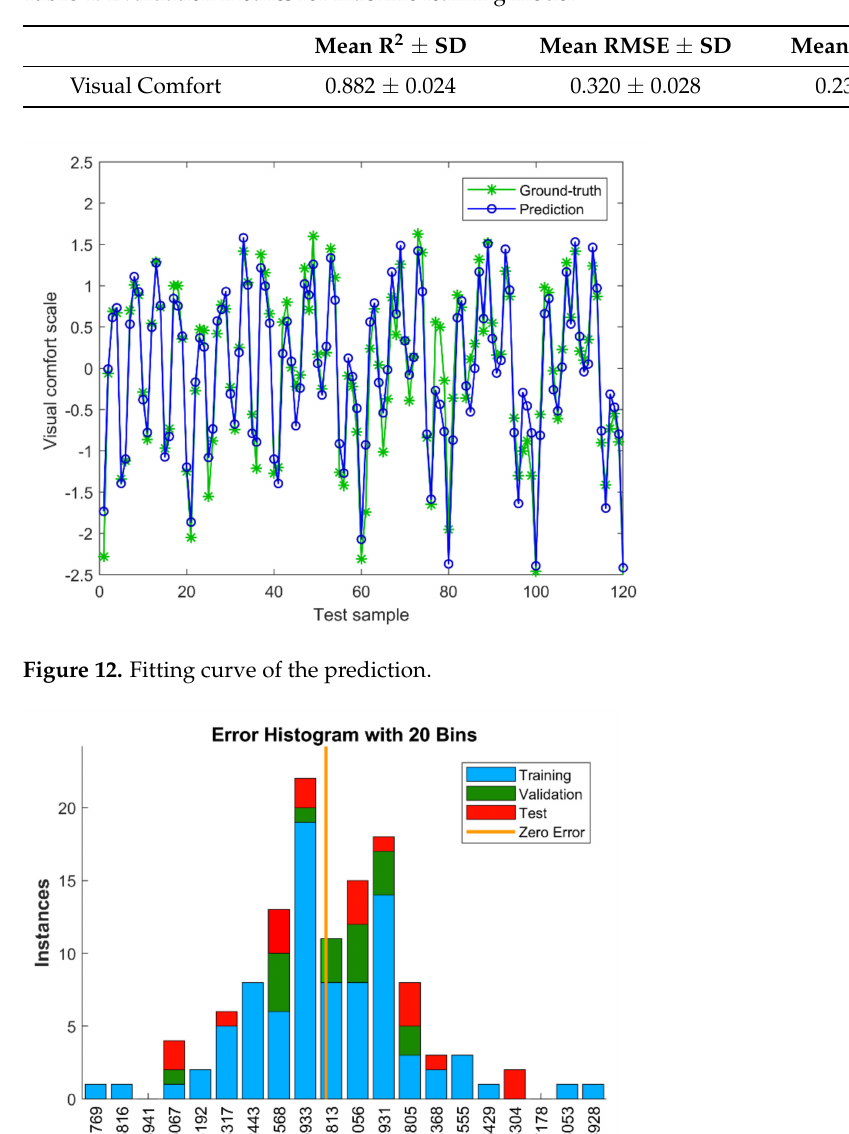
Table 4. Evaluation metrics for machine learning model.